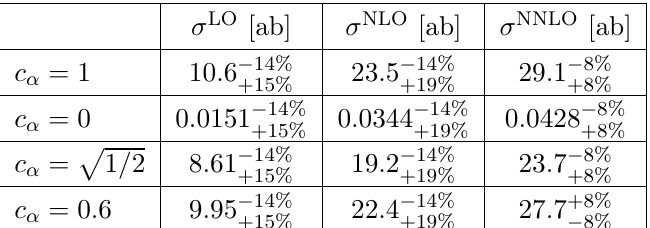
Table 2 . Fiducial cross sections for pp ! H ! ZZ (cid:3) ! e (cid:0) e + (cid:22) (cid:0) (cid:22) + at LO, NLO and NNLO at the 13 TeV LHC, for four values of c (cid:11) . The cross section is shown for the central scale choice (cid:22) = m H = 2. The subscripts (superscripts) indicate the scale variation obtained by varying by a factor of 1/2 (2). The kinematic cuts and parameter choices are described in the